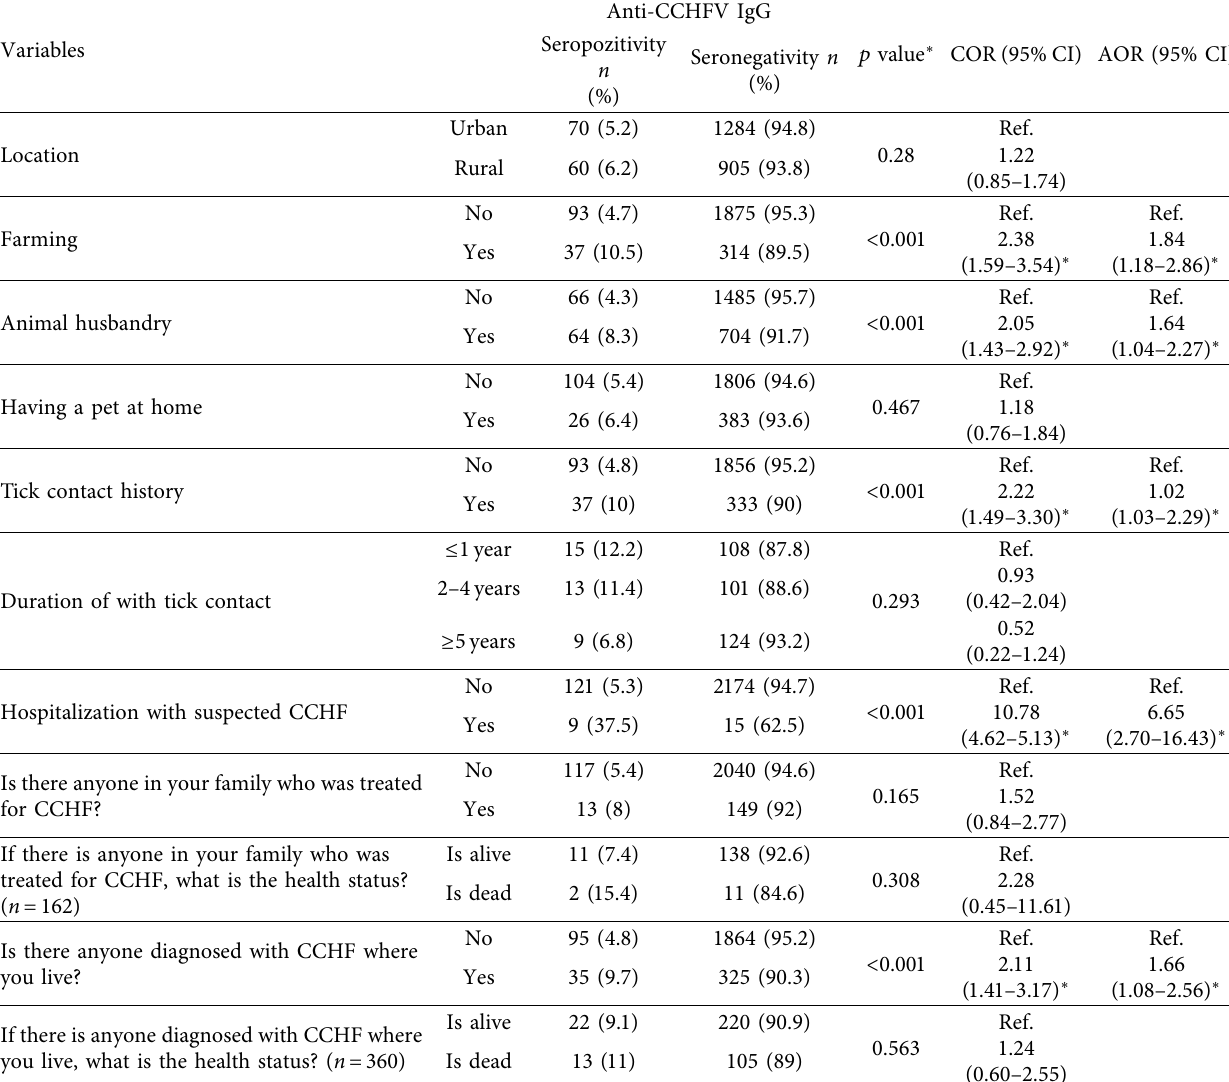
Table 5: Logistic regression analysis of some CCHF-related risk factors for anti-CCHFV IgG seropositivity of the participants ( n � 2319).